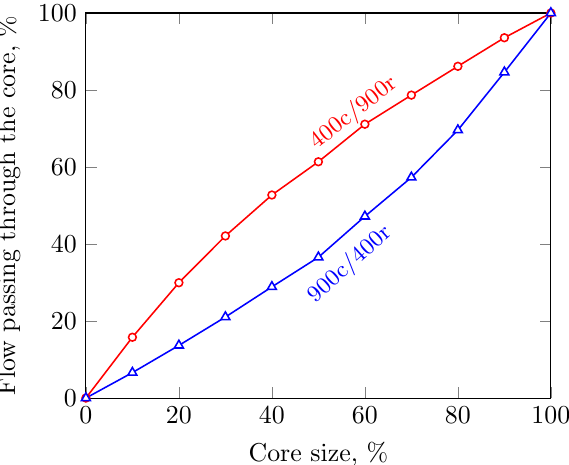
Figure 10. Percentage of the flow passing through the core as a function of the core